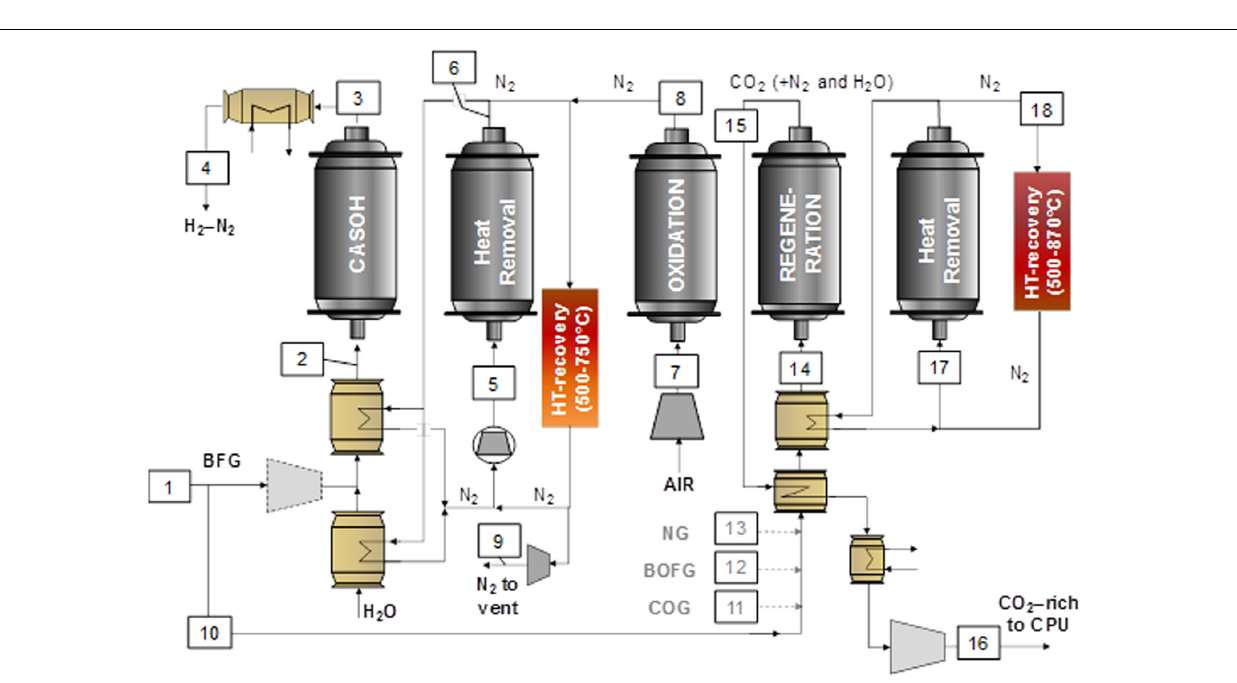
FIGURE 2 | Possible levels of integration of the Ca-Cu looping process in a steel mill (thicker arrows are used to highlight the main mass flow rates).